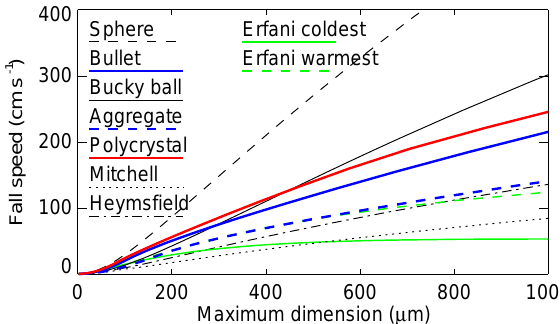
Figure 14. Ice crystal fall speeds at 350mb and 233K for derived ice properties as follows (see legend): a sphere, six-arm rosettes fol- lowing the bullet and Bucky ball models, 12-arm aggregates follow- ing the bullet model, the polycrystal model, five-arm rosettes from Mitchell et al. (1996), and cirrus crystals from Heymsfield et al. (2002) and from Erfani and Mitchell (2016) assuming ice crys- tal properties at − 55 to − 65 ◦ C (coldest range fitted) and − 20 to − 40 ◦ C (warmest; see text).